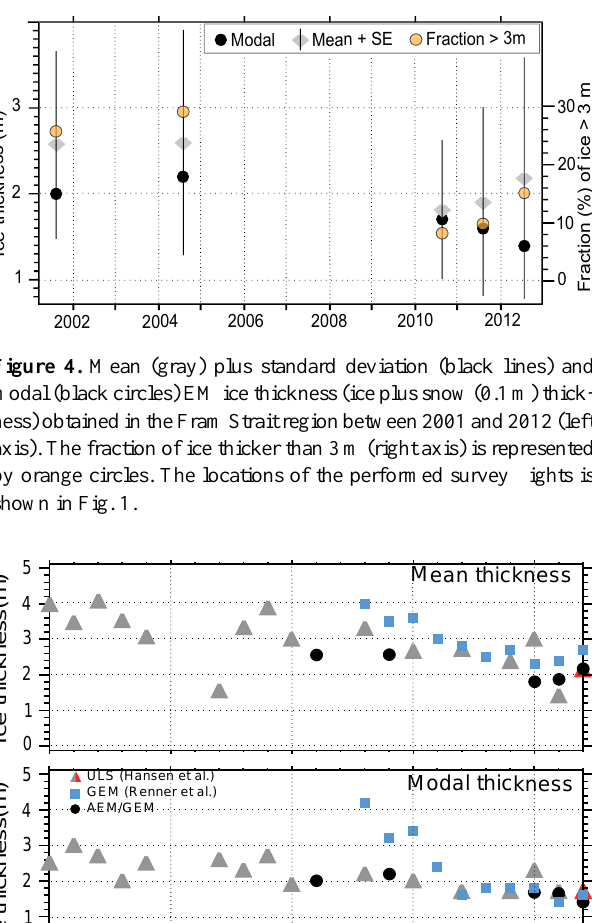
regridded to the sampling interval of the airborne data and ice thinner than 0.15 m and open water has been excluded from the analysis of the AEM measurements (see Sect.